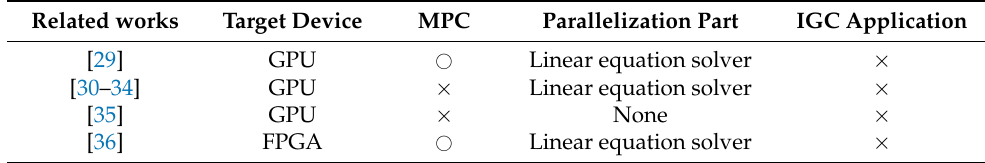
Table 1. Works related to the acceleration of